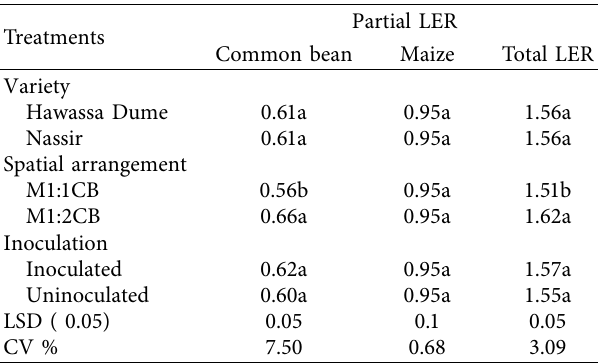
Table 12: Partial and total land equivalent ratio (LER) from the common bean-maize